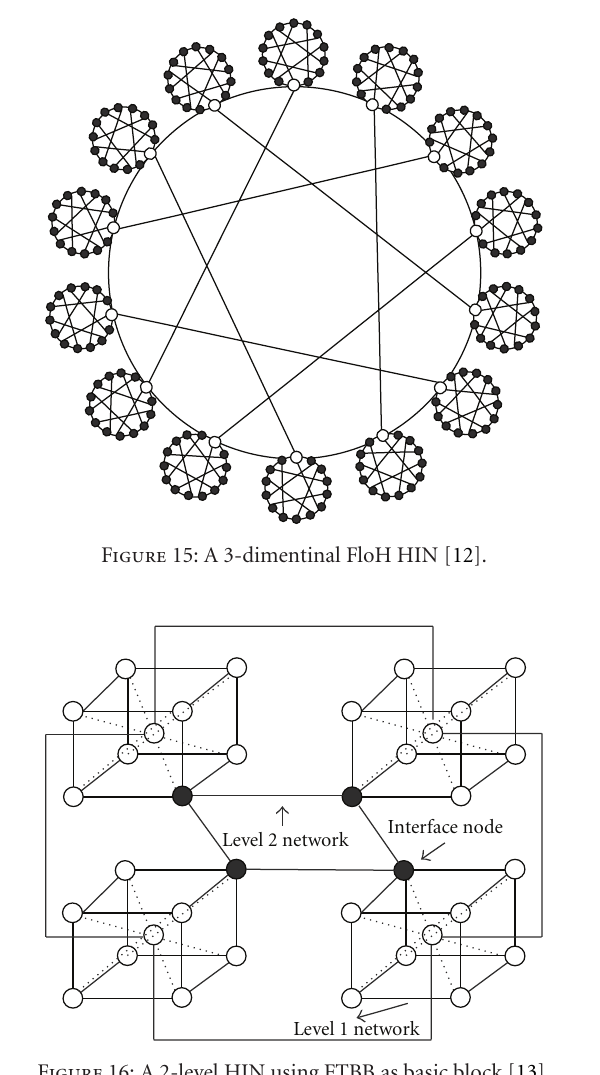
Figure 16: A 2-level HIN using FTBB as basic block